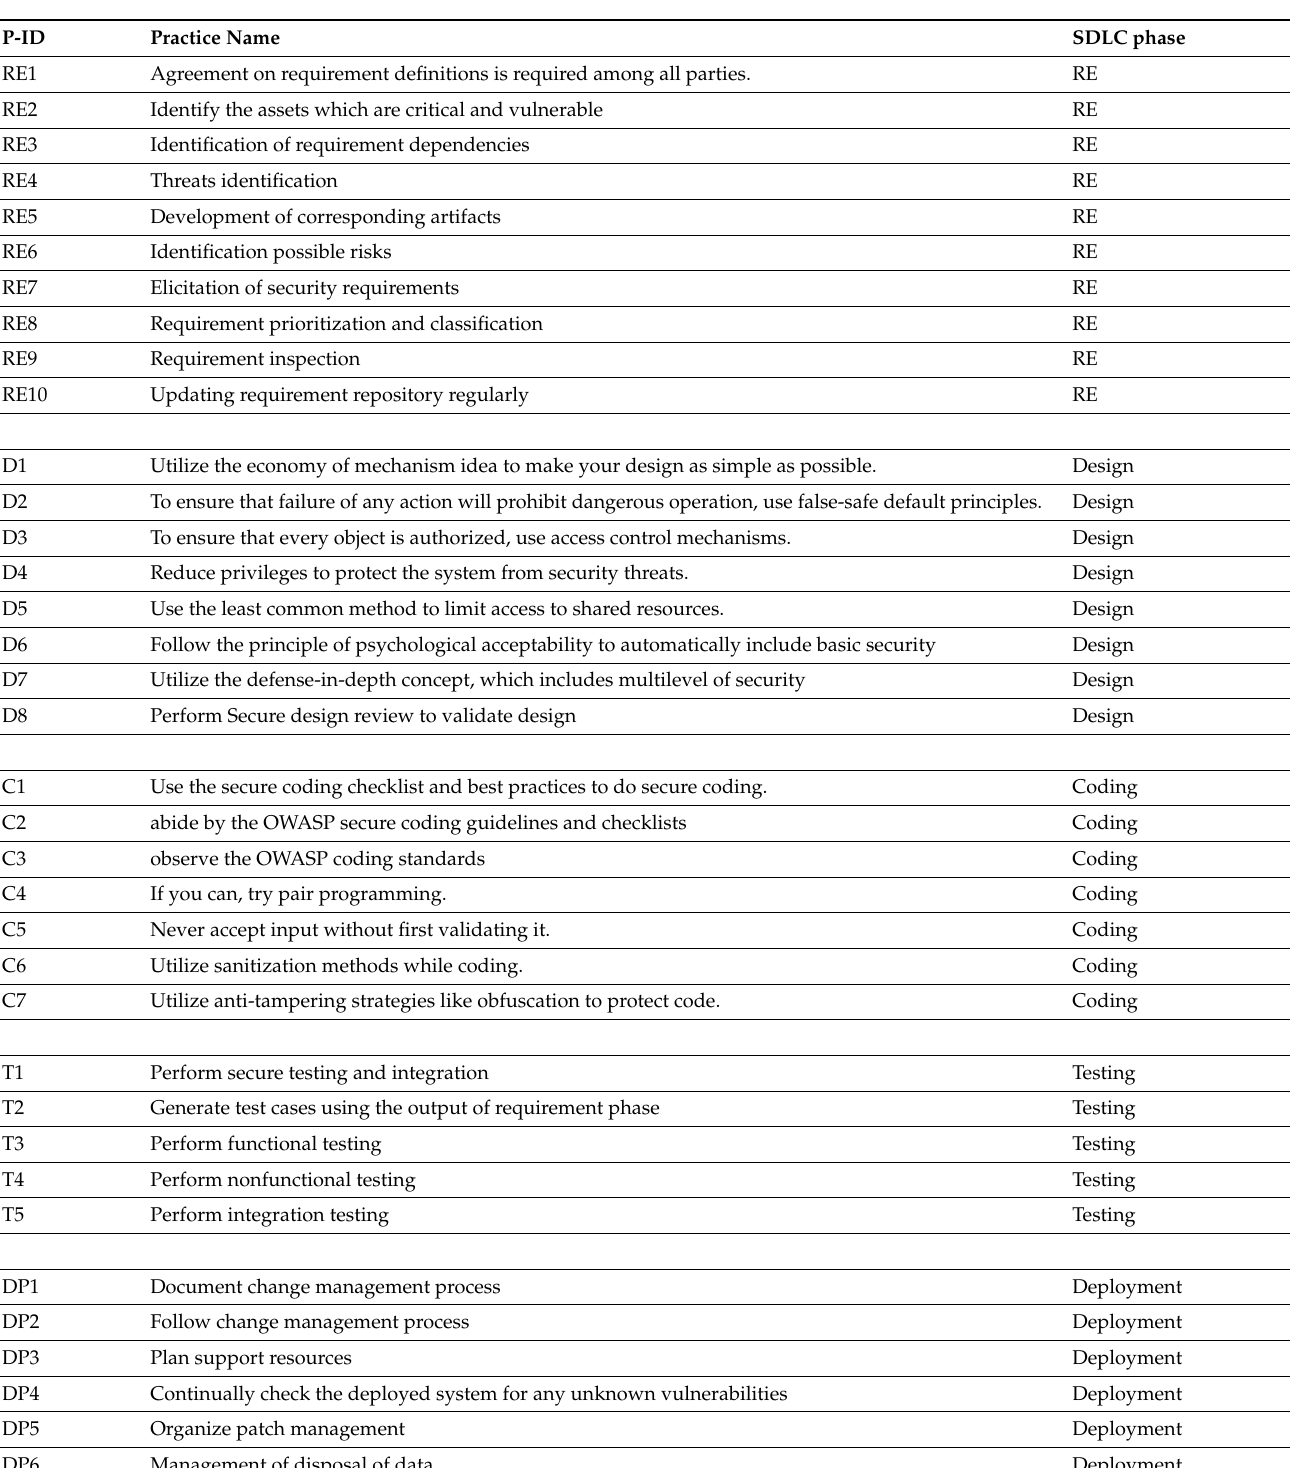
Table A1. List of identified security practices for